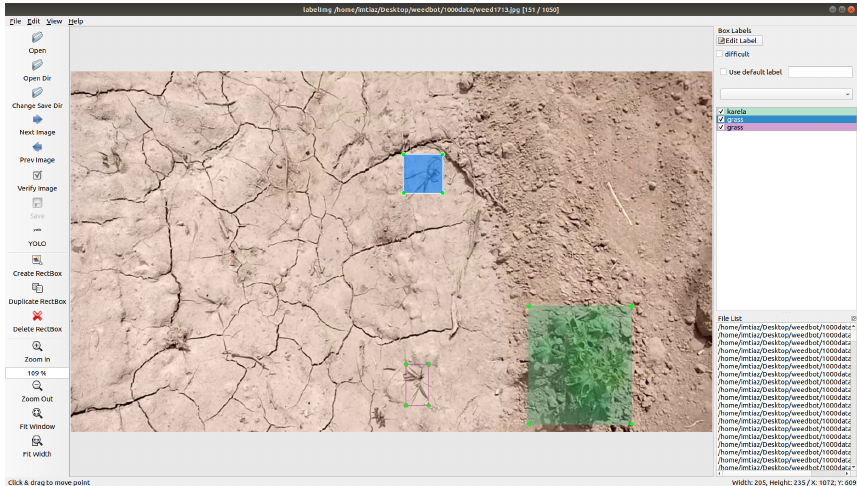
Figure 5. An annotated sample image using an open source tool